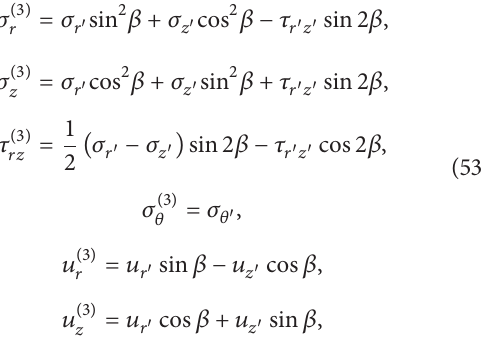
Figure 6: The stress analysis of calculation point by the force on the small